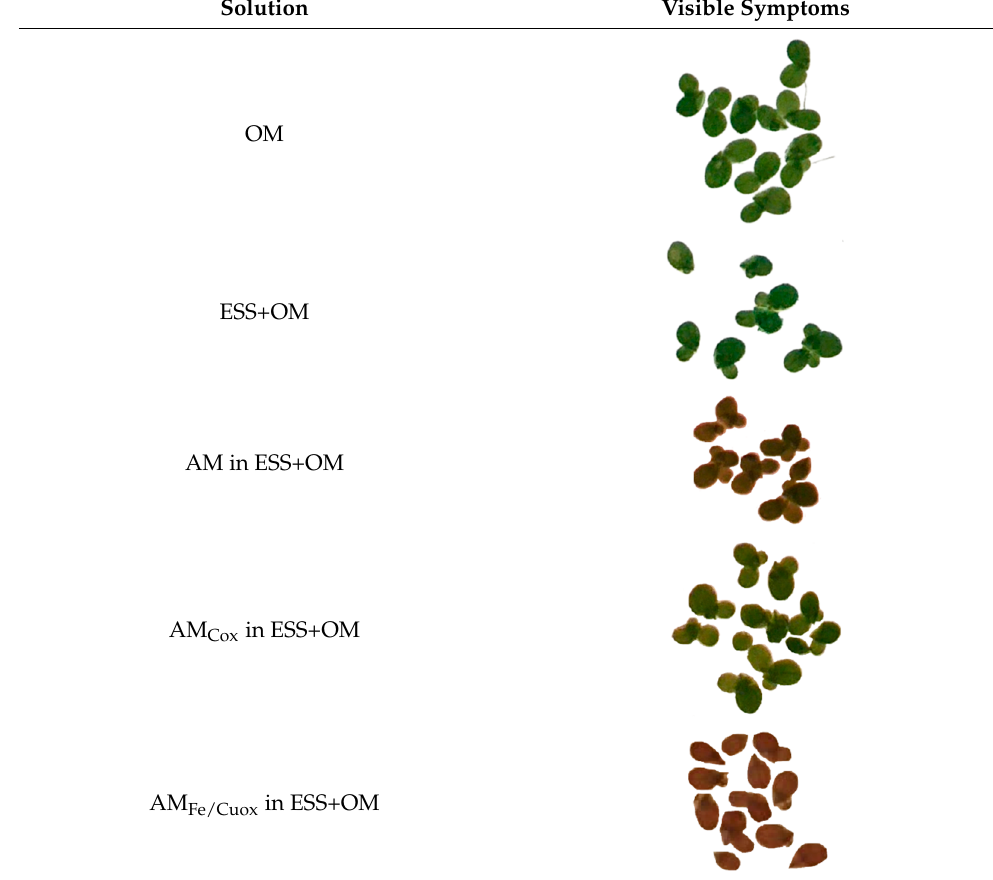
Table 4. The leaves of L. minor were exposed to OM, ESS+OM; AM in ESS+OM; AM Cox in ESS+OM; AM Fe/Cuox in ESS+OM.